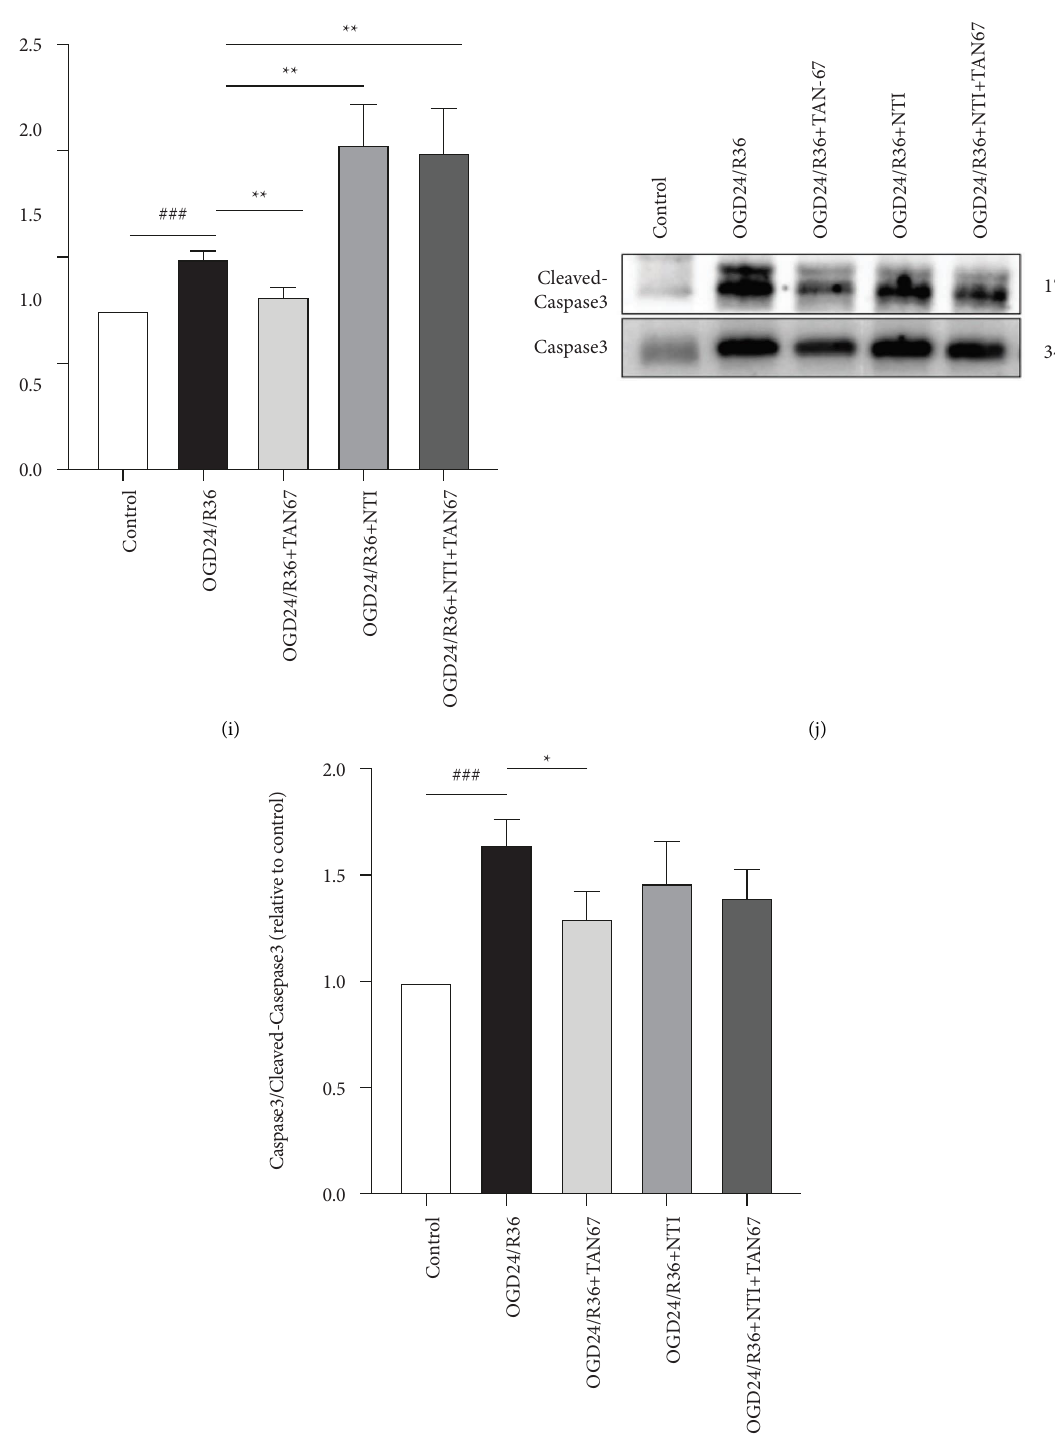
Figure 5: Te DOR agonist TAN-67 suppresses TNF- α levels and the expression of necroptotic and apoptotic proteins in ARPE19 cells induced by OGD24/R36. (a) TNF- α levels in cell lysates from each group were measured by ELISA ( n � 5 per group). (b–c) Te level of DOR expression was examined by Western blotting, and the density values were normalized to the levels of β -actin ( n � 3 per group). (d–k) Western blot showing the activation or total abundance of p-RIP1 (RIP1), p-RIP3 (RIP3), p-MLKL (MLKL), and cleaved Caspase-3 (Caspase-3) as indicated ( n � 3 per group). P-RIP1, phosphorylated RIP1; p-RIP3, phosphorylated RIP3; p-MLKL, phosphorylated MLKL. Data are presented as means ± SEM, and group diferences were analyzed by one-way ANOVA with Dunnett’s post hoc test. ## P < 0 . 01, ### P < 0 . 001 compared with the control group; ∗ P < 0 . 05, ∗ ∗ P < 0 . 01, ∗ ∗ ∗ P < 0 . 01, compared with the OGD24/R36